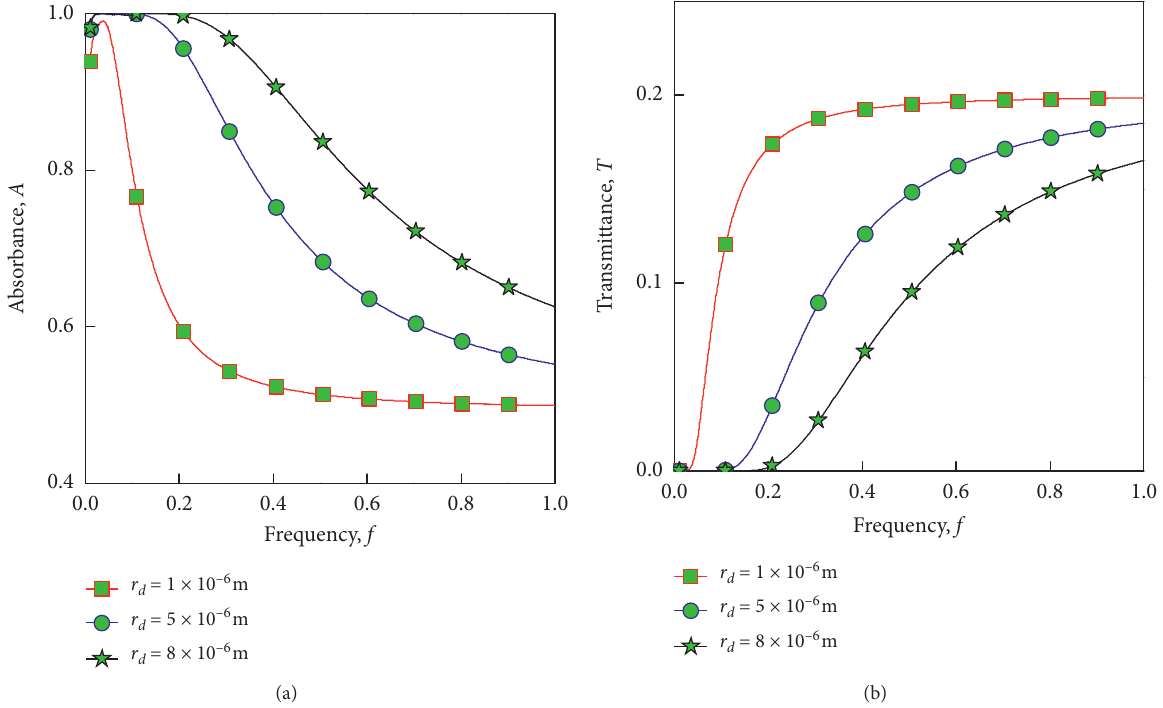
Figure 7: Absorbance and transmittance versus wave frequency for different radii of dust particles in a dusty plasma